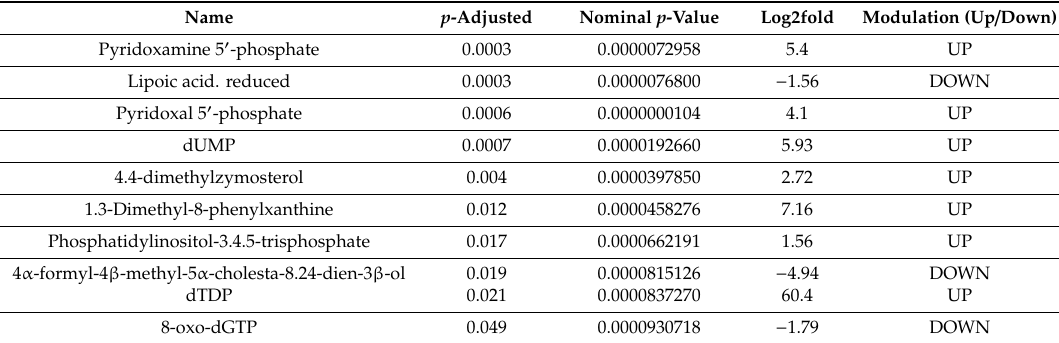
Figure 3. Modulated metabolites between PRE and POST run athletes. The t -test was considered as significant only for features with an adjusted p -value ≤0.05 (red circles). Table 2. List of significantly modulated metabolites.